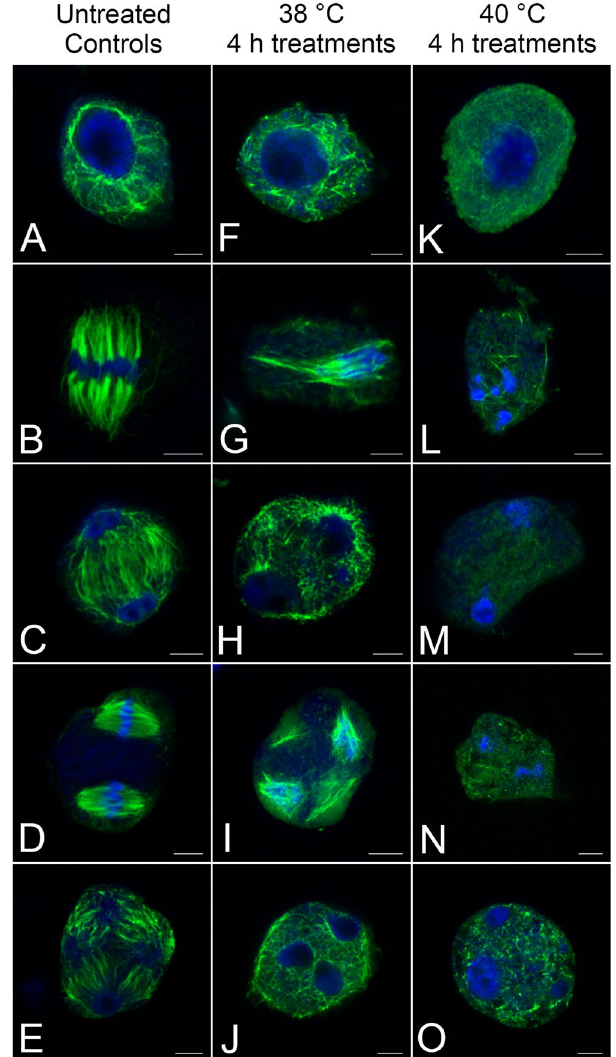
Figure 6. Defects in microtubule distribution and chromosome behaviours induced by high temperature treatments. ( A–E ) Microtubular distributions and chromosome behaviours under normal conditions. ( A ) The network of microtubules in prophase I. ( B ) Connections between chromosomes and microtubules in a metaphase I dipolar spindle. ( C ) Phragmoplast microtubules located between two daughter nuclei in telophase I. ( D ) Two spindles with parallel arrangement in metaphase II. ( E ) Nuclear-based RMSs and four separated daughter nuclei in telophase II. ( F–J ) Defects in microtubular arrangement and abnormal chromosome behaviours after treatment at 38 °C for 4 h. ( F ) Microtubules become fragments in prophase I. ( G ) Metaphase I spindle damage, resulting in unrestrained chromosomes in the cytoplasm. ( H ) High temperature treatment resulting in destroyed phragmoplast with a micronucleus. ( I ) Damaged spindles in metaphase II. ( J ) Failure of RMS formation due to heat stress. ( K–O ) Damages to the microtubular arrangement and chromosome behaviours after treatment at 40 °C for 4 h. ( K ) A cell in prophase I shows almost no microtubules. ( L ) A few microtubular fragments remaining in the cytoplasm of a cell in metaphase I. ( M ) Completely depolymerised microtubules in telophase I. ( N ) No visible spindles and just a few microtubular fragments in metaphase II, resulting in excessive condensation of chromosomes. ( O ) Depolymerised microtubules causing fusion of nuclei and formation of micronuclei in telophase II. Bars = 5 μ